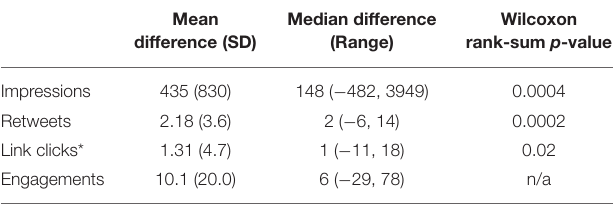
TABLE 1 | Within abstract differences (Visual minus Text) N =